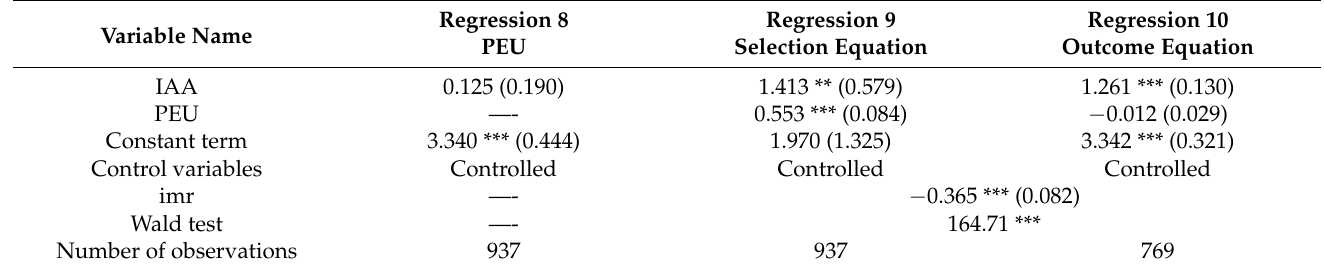
Table 8. Results of the mediating effect test for perceived ease of use.